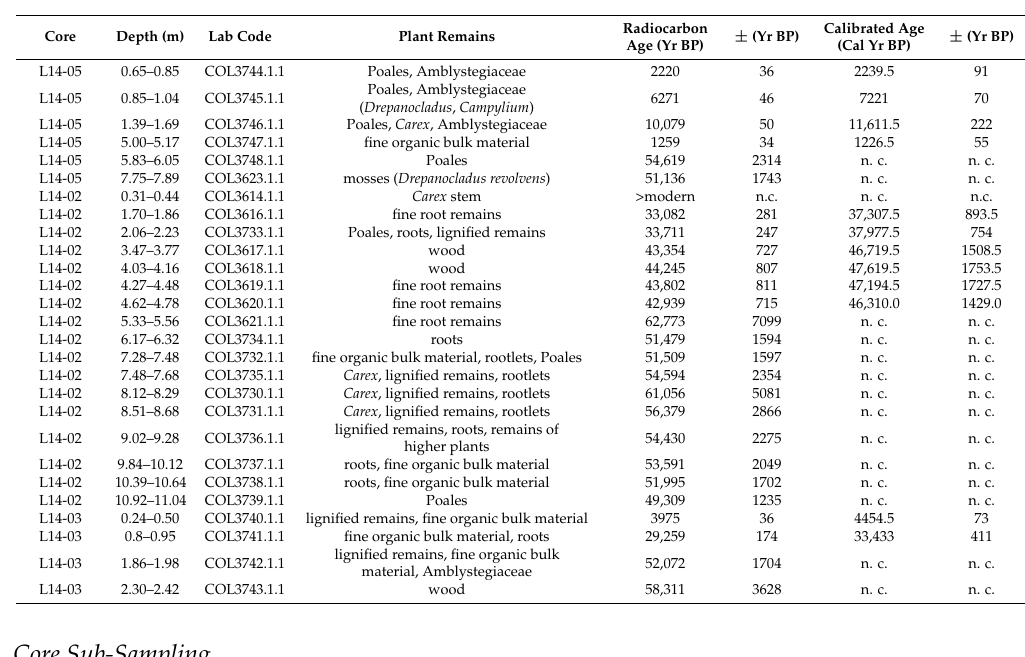
Table 1. Accelerator mass spectrometry (AMS) radiocarbon ages (years before present, yr BP) and calibrated ages (cal yr BP) based on the IntCal13 calibration curve (2-sigma). Ages exceeding the limit for AMS radiocarbon dating were not calibrated (n.c: not